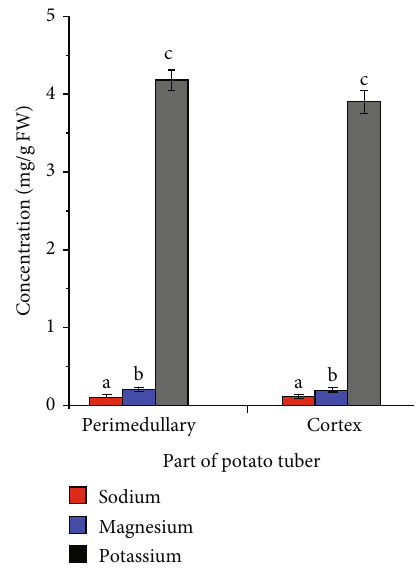
Figure 2: Distribution of potassium, sodium, and magnesium in the perimedullary and cortex parts of potato tuber. a – c Bars of the same mineral (same colour) with the same alphabets are not signi fi cantly di ff erent ( p > 0 : 05